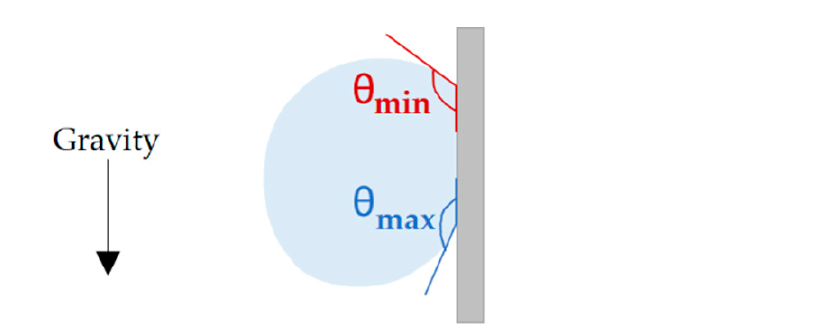
Figure 6. SEM images of the samples textured in ambient air or under a CO 2 flow for which the top of the square pillars was irradiated using different fluences. Images from ( A – D ) are samples tex ‐ tured in ambient air. Images from ( E – H ) are samples textured under a CO 2 flow. Images denoted with the number “1” are wide views of the textured area, while the number “2” is a focus on one square pillar from the wide view.